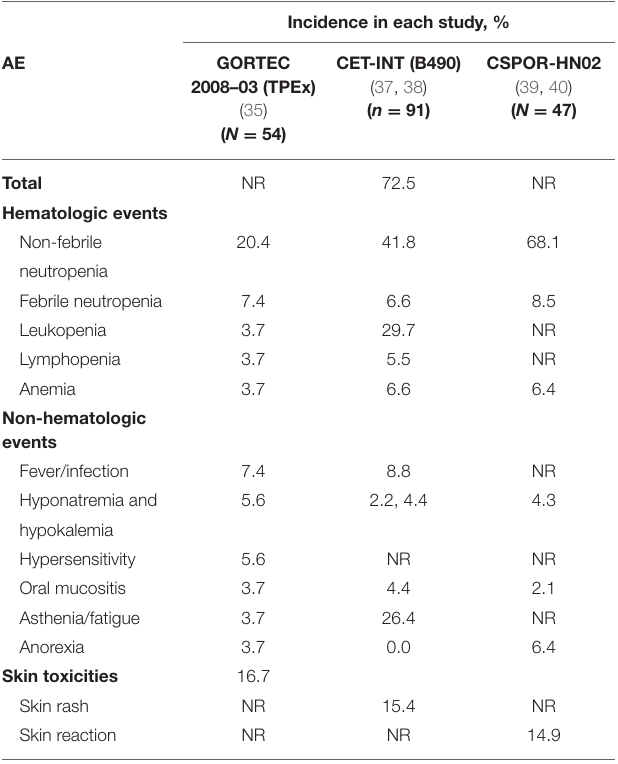
TABLE 3 | Safety profile of cetuximab + platinum + taxane: grade ≥ 3 AEs occurring in ≥ 5% of patients in the cetuximab + platinum + taxane arm. Incidence in each study,